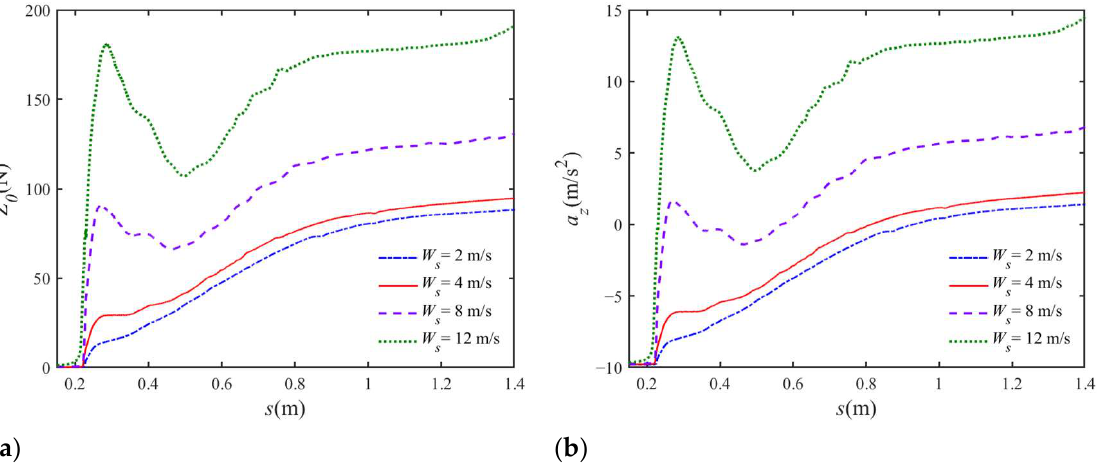
Figure 13. Comparison of the displacement curve of ( a ) vertical force and ( b ) vertical acceleration for the water entry of UAUV with different initial velocities.